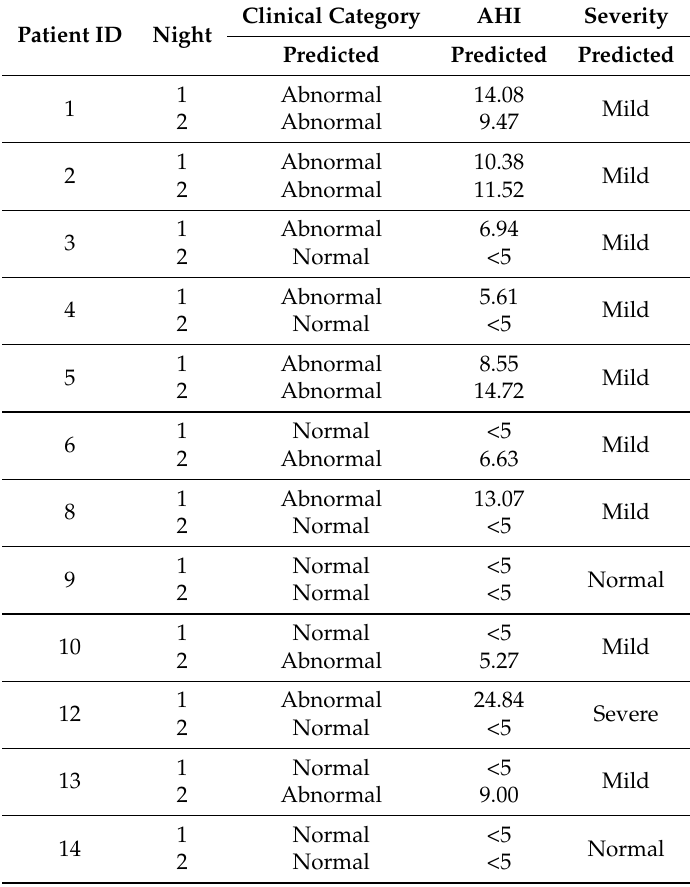
Table 4. Estimated AHI when monitoring patients at home with LCs device only.